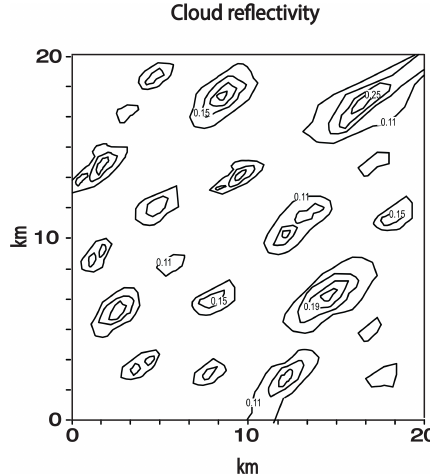
Figure 2. Spatial distribution of cloud reflectivity, which is unitless and observed by the COMS at 14:00LST on 13 April 2016 in the simulation domain. Contours are at 0.11, 0.15, 0.19 and 0.25.